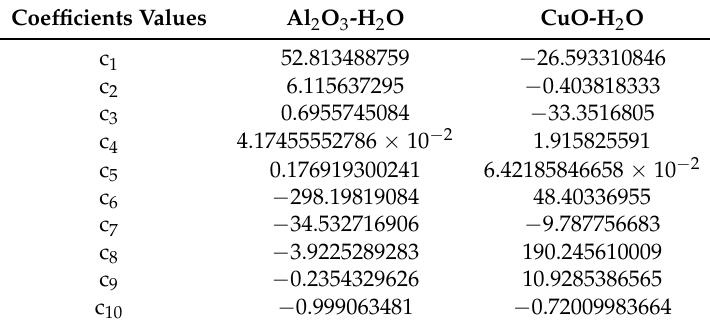
Table 2. Coefficients values of the Al 2 O 3 -H 2 O and CuO-H 2 O